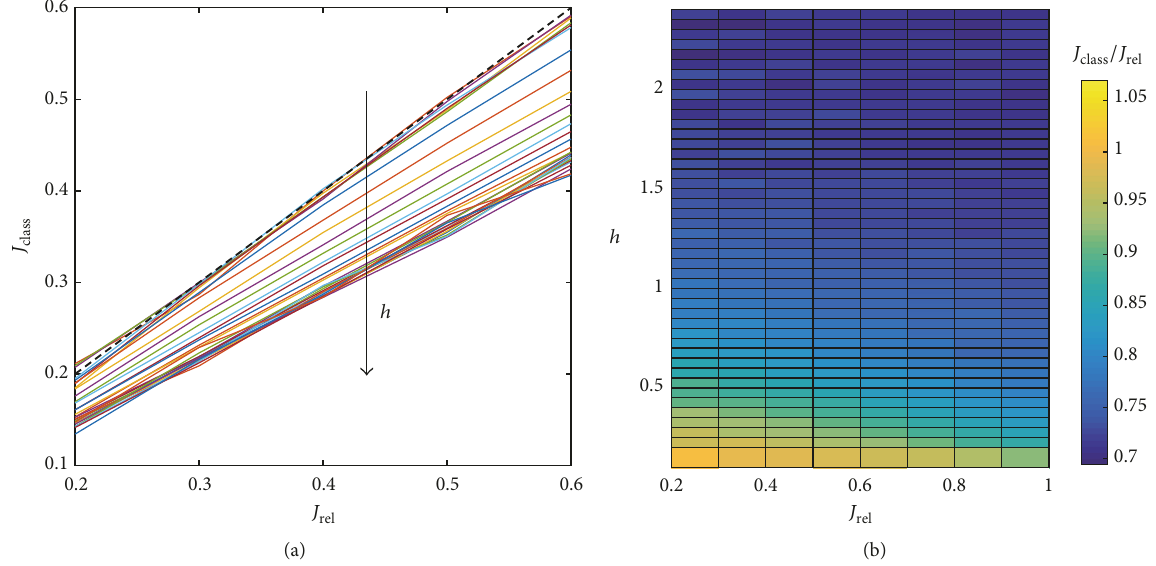
Figure 4: Comparison between relativistic and classical model . We performed numerical experiments where we obtained 𝑌(𝑆,𝐽 rel ) for the relativistic model by solving the self-consistent equation (39). From this data we inferred the expected classical coupling 𝐽 class by inverting the self-consistent equation (22). We repeated the same operations for several values of 𝑆 and 𝐽 rel . In (a) we show the inferred 𝐽 class versus the fixed 𝐽 rel : different colors represent different values of 𝑆 and the identity function is also shown for reference (dashed, black curve). Notice that, in general 𝐽 class < 𝐽 rel and the inequality is enhanced as 𝑆 grows. In (b) we show a contour plot for the ratio 𝐽 class /𝐽 rel versus ℎ = log (𝑆)/2 and 𝐽 rel . Again, one can notice that, in general, 𝐽 class /𝐽 rel < 1 and this inequality is enhanced for relatively large values of 𝑆